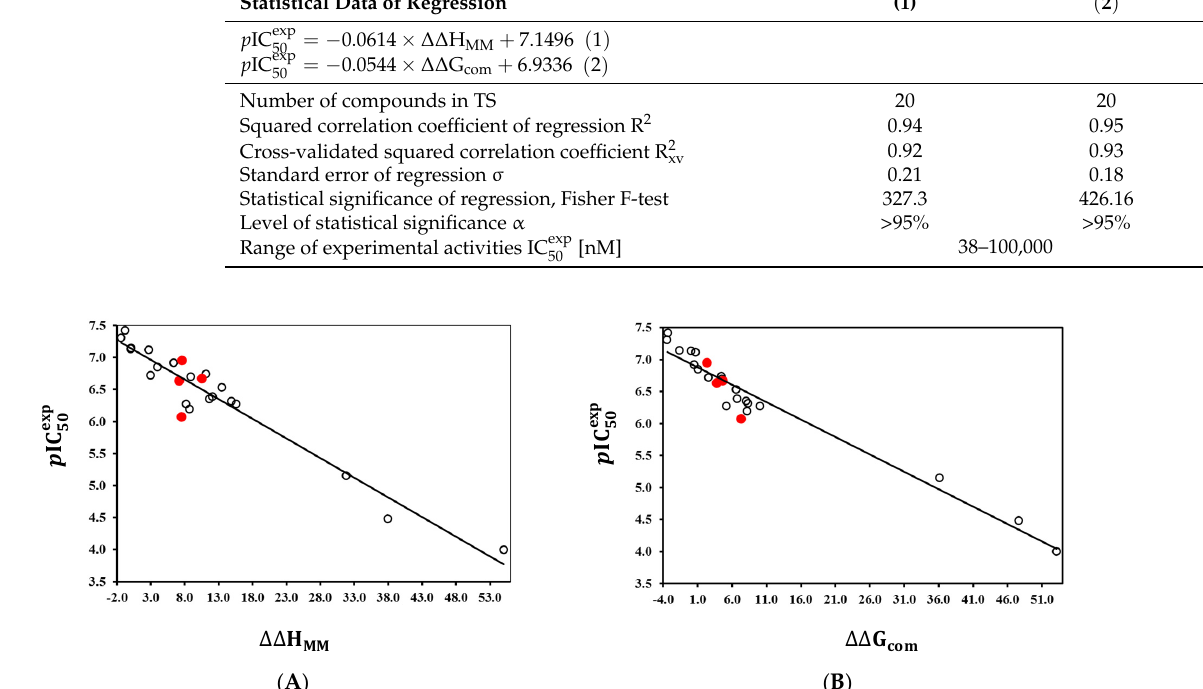
and relative enthalpic 50